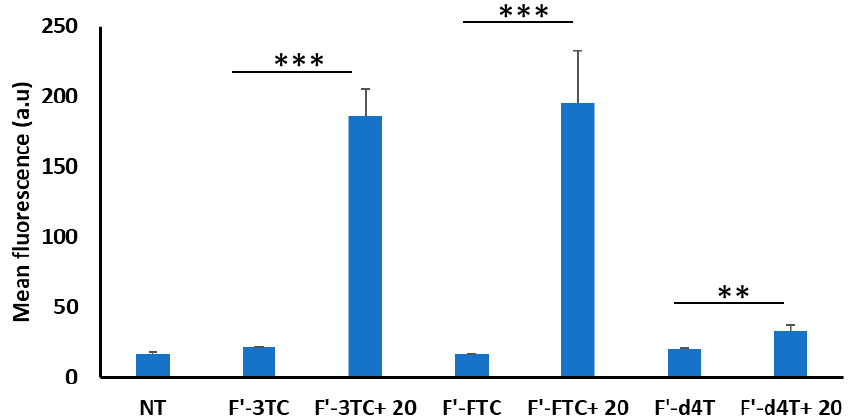
Figure 4. The cellular uptake of fluorescently labeled anti-HIV drugs (F (cid:48) -FTC, F (cid:48) -3TC, and F (cid:48) -d4T) in the presence of tricyclic peptide 20 in MDA-MB-231 cells (if p < 0.01 then **, if p < 0.001 then